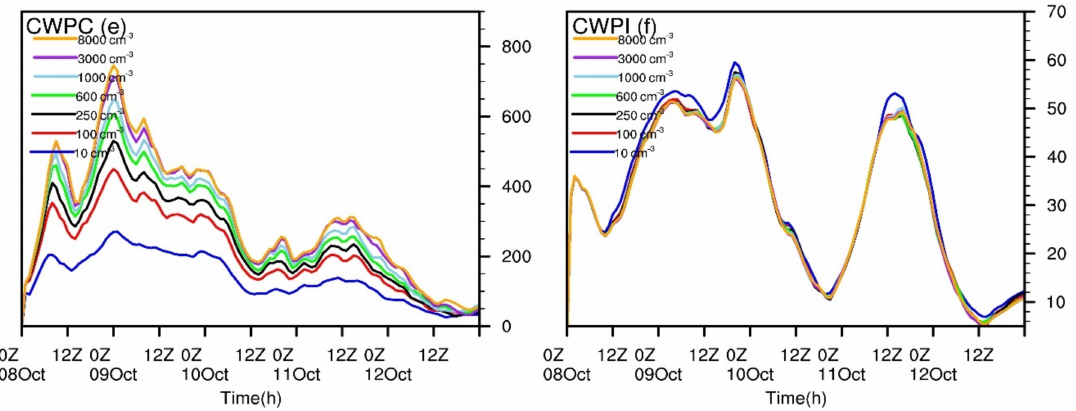
Figure 7. Temporal changing of area-averaged Rc ( a ) ( µ m), Ri ( b ) ( µ m), CODC ( c ), CODI ( d ), CWPC ( e ) (g m − 2 ), CWPI ( f ) (g m − 2 ) of Region A with different CCN 0 from 8 to 12